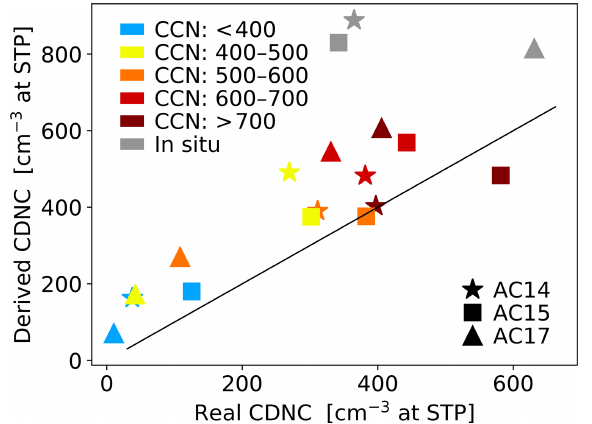
Figure 7. Comparison of real (i.e., CDP and CAS measured) CDNC with CDNC as derived using the Freud et al. (2011) method. Real CDNC for model data is average modeled CDNC in the model do- main. Symbols indicate date; colors indicate model bin or in situ data. The 1-to-1 line is for reference. These are the same data as in Figs. 5d–f and